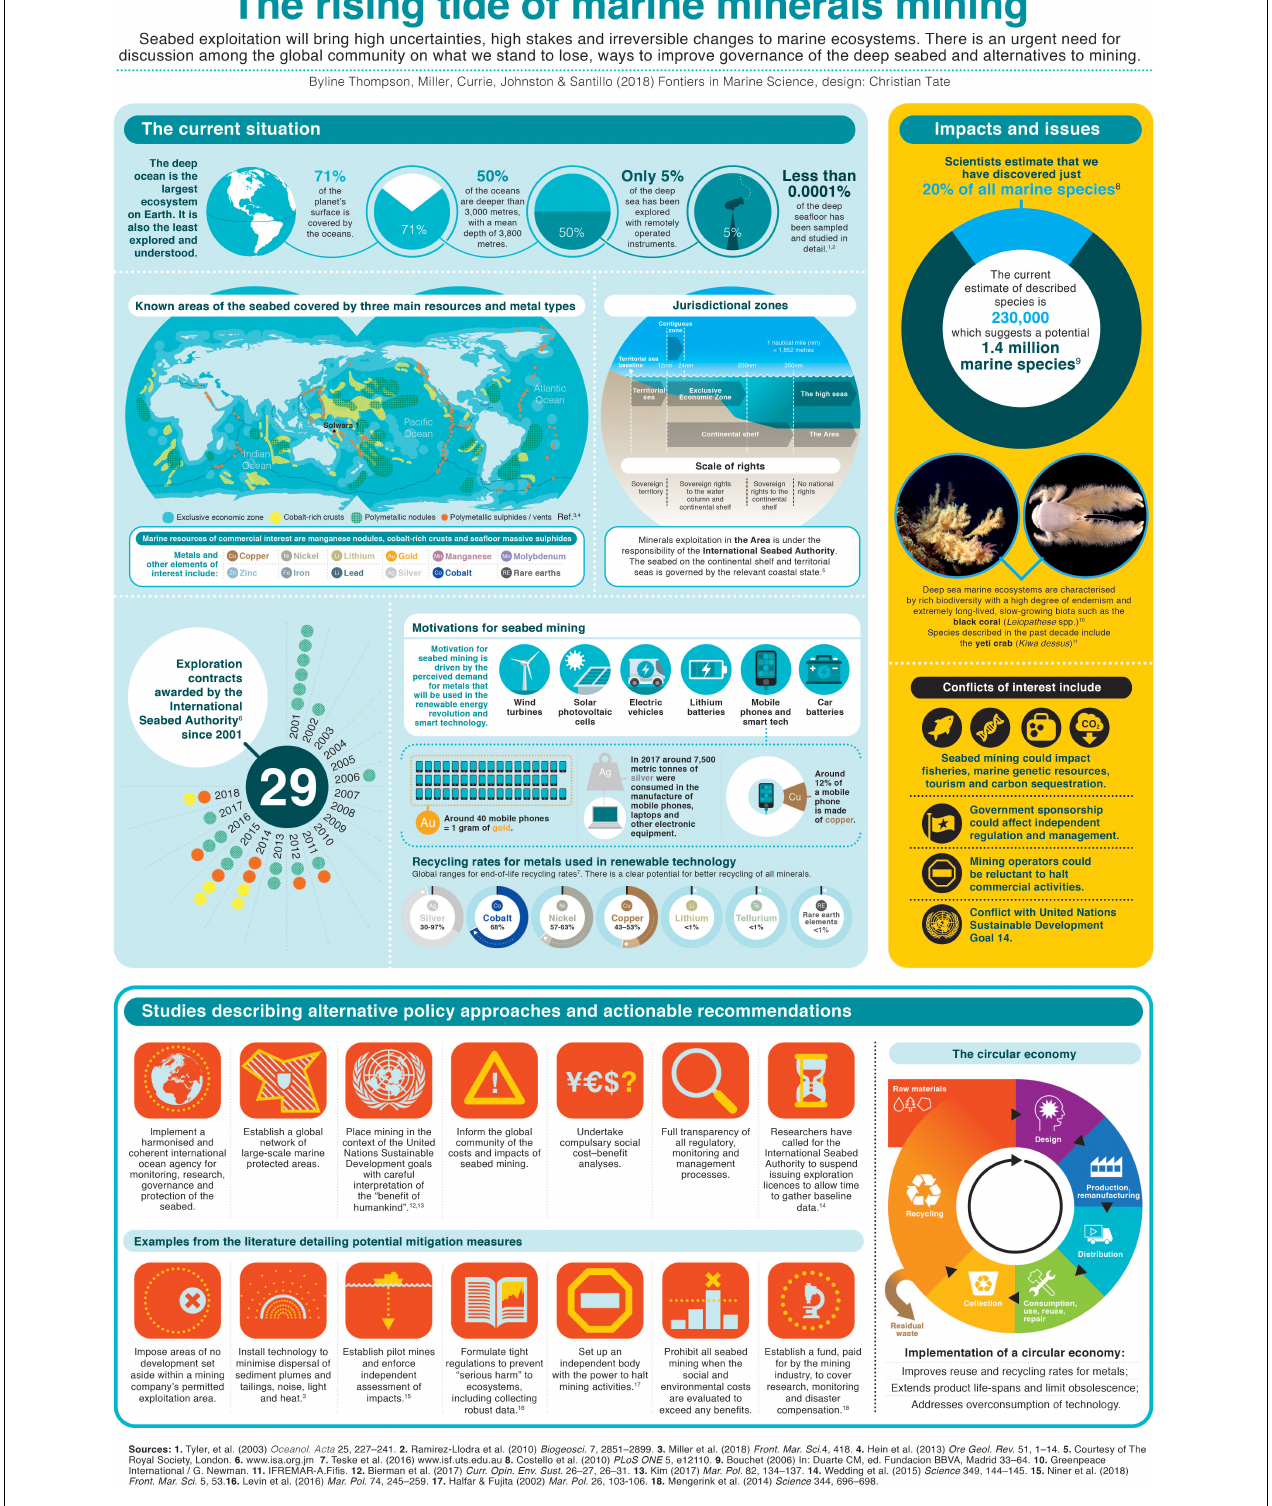
FIGURE 1 | The rising tide of marine minerals mining. An infographic that outlines the current situation and impacts of seabed mining including potential mitigation measures and actionable recommendations.